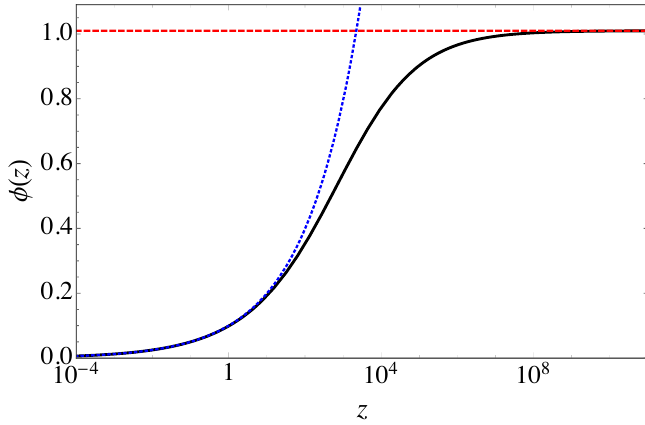
Figure 2 . Numeric solution of the bulk pro(cid:12)le (cid:30) ( z ) in the toy model. ( Black, solid ): exact numeric solution; ( red, dashed ): asymptotic value at (cid:30) = (cid:30) = (cid:21)z d (cid:0) (cid:1) R . Parameters are (cid:1) R =1 : 7, (cid:21) =0 : 1, g 4 =0 : 5, z UV =10 (cid:0) 4 , d =2, all in units of ‘ AdS